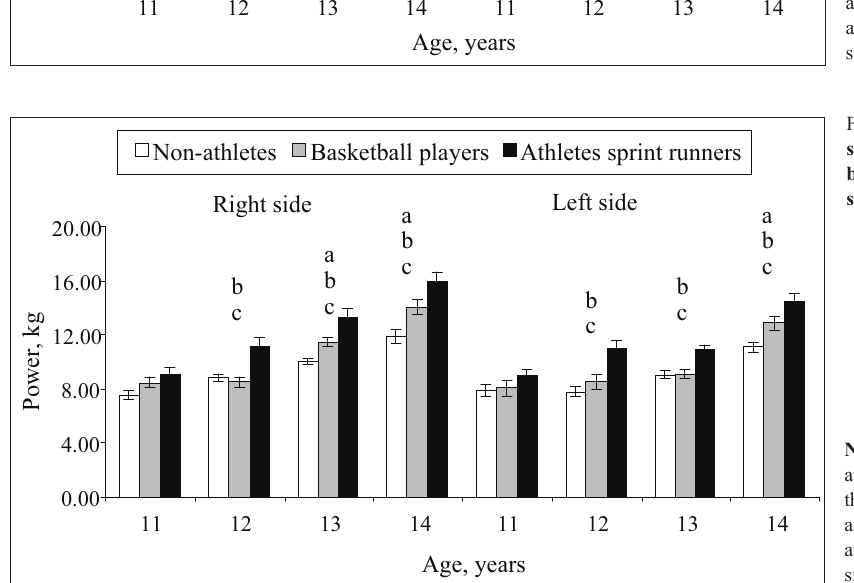
Note. The difference between: the non- athletes and basketball players – a, the athletes sprint runners and non- athletes – b, the basketball players and athletes sprint runners – c; statistically significant at p < 0.05.